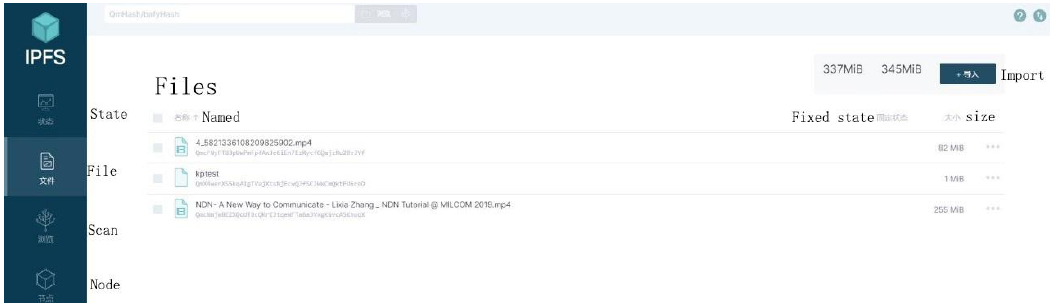
Figure 3. Data communication and forwarding process.